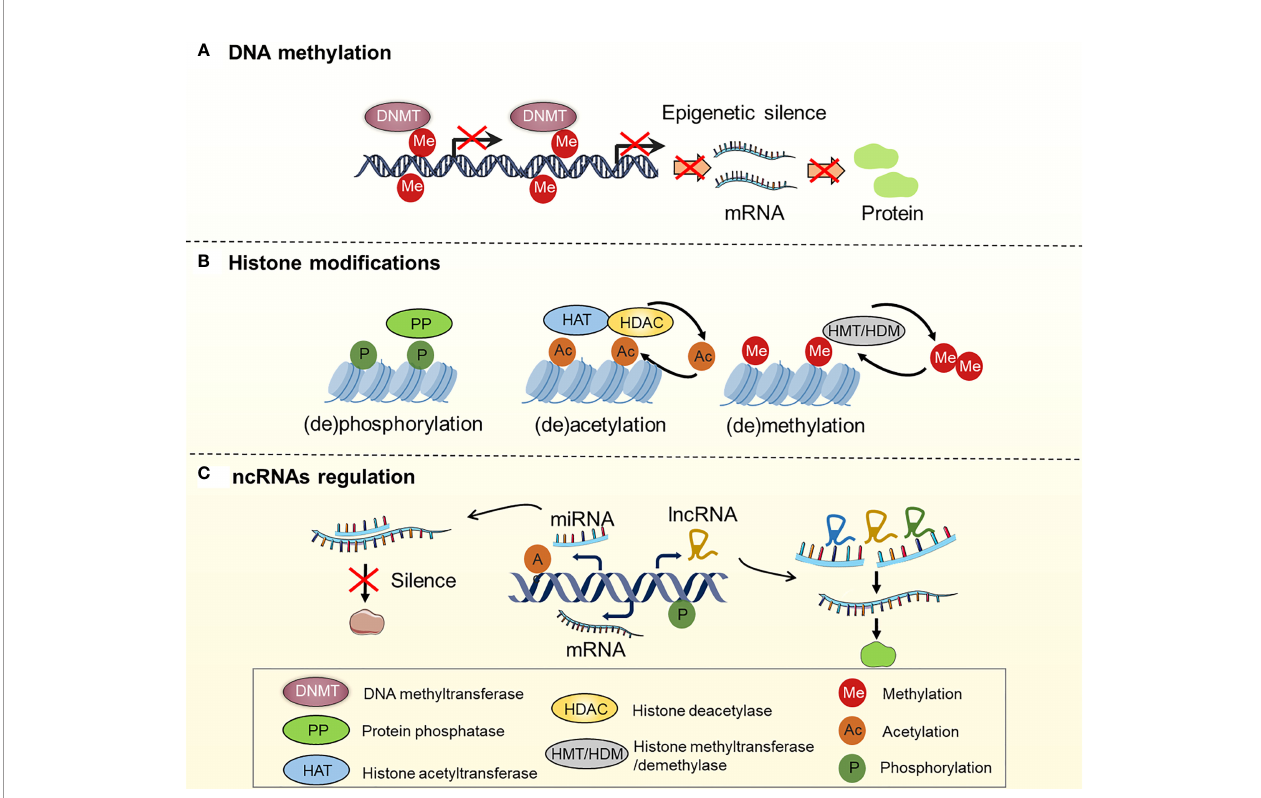
FIGURE 2 | Regulation of DNA methylation, histone modi fi cations and ncRNAs in OC. (A) Genes are silenced by hypermethylation, which is catalyzed by DNA methyltransferases (DNMTs); (B) Histone modi fi cations, including histone (de)phosphorylation, (de)acetylation, (de)methylation, etc. Histone (de)phosphorylation is catalyzed by protein phosphatase (PP). Histone (de)acetylation is catalyzed by histone acetyltransferase (HAT) and histone deacetylase (HDAC). Histone (de) methylation is catalyzed by histone methyltransferase (HMT) and histone demethylase (HDM); (C) ncRNAs regulation: miRNAs and lncRNAs regulate gene expression by interacting with